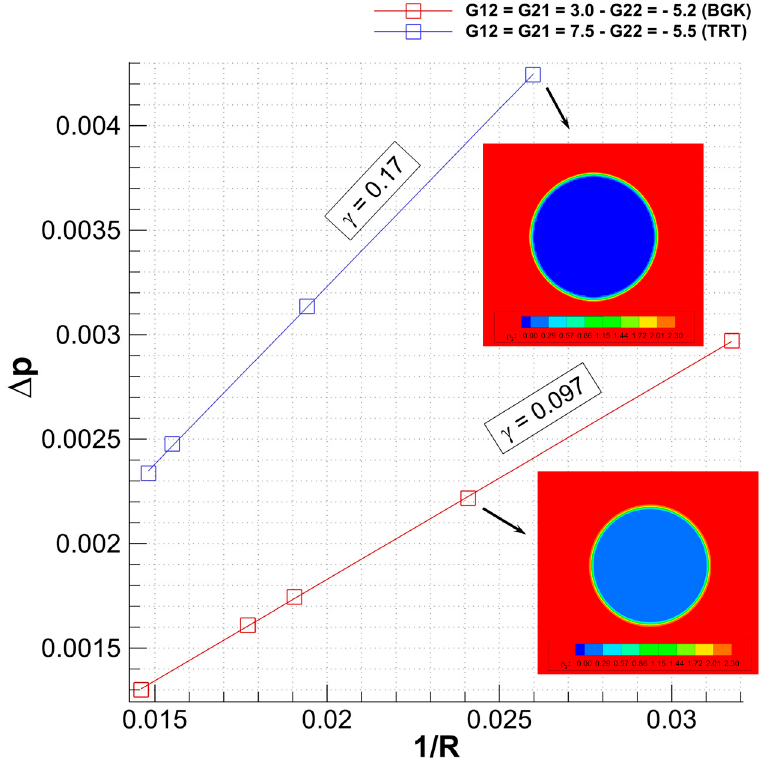
Figure 3. Young–Laplace test for the two limiting surface tension cases and density ratio ≈ 10 (two phase two component). Surface tensions and density contours are presented in LU.